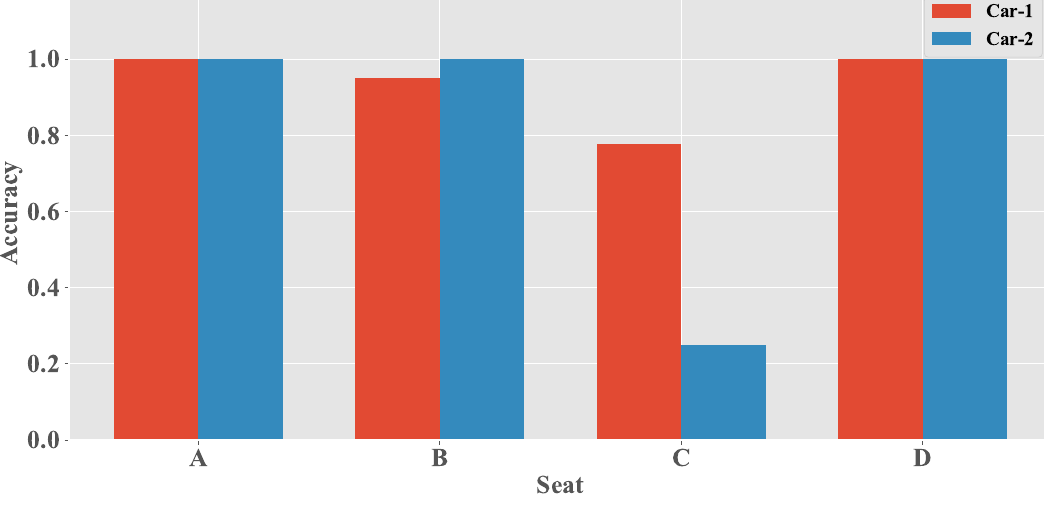
Figure 9. Door detection performance in different kinds of